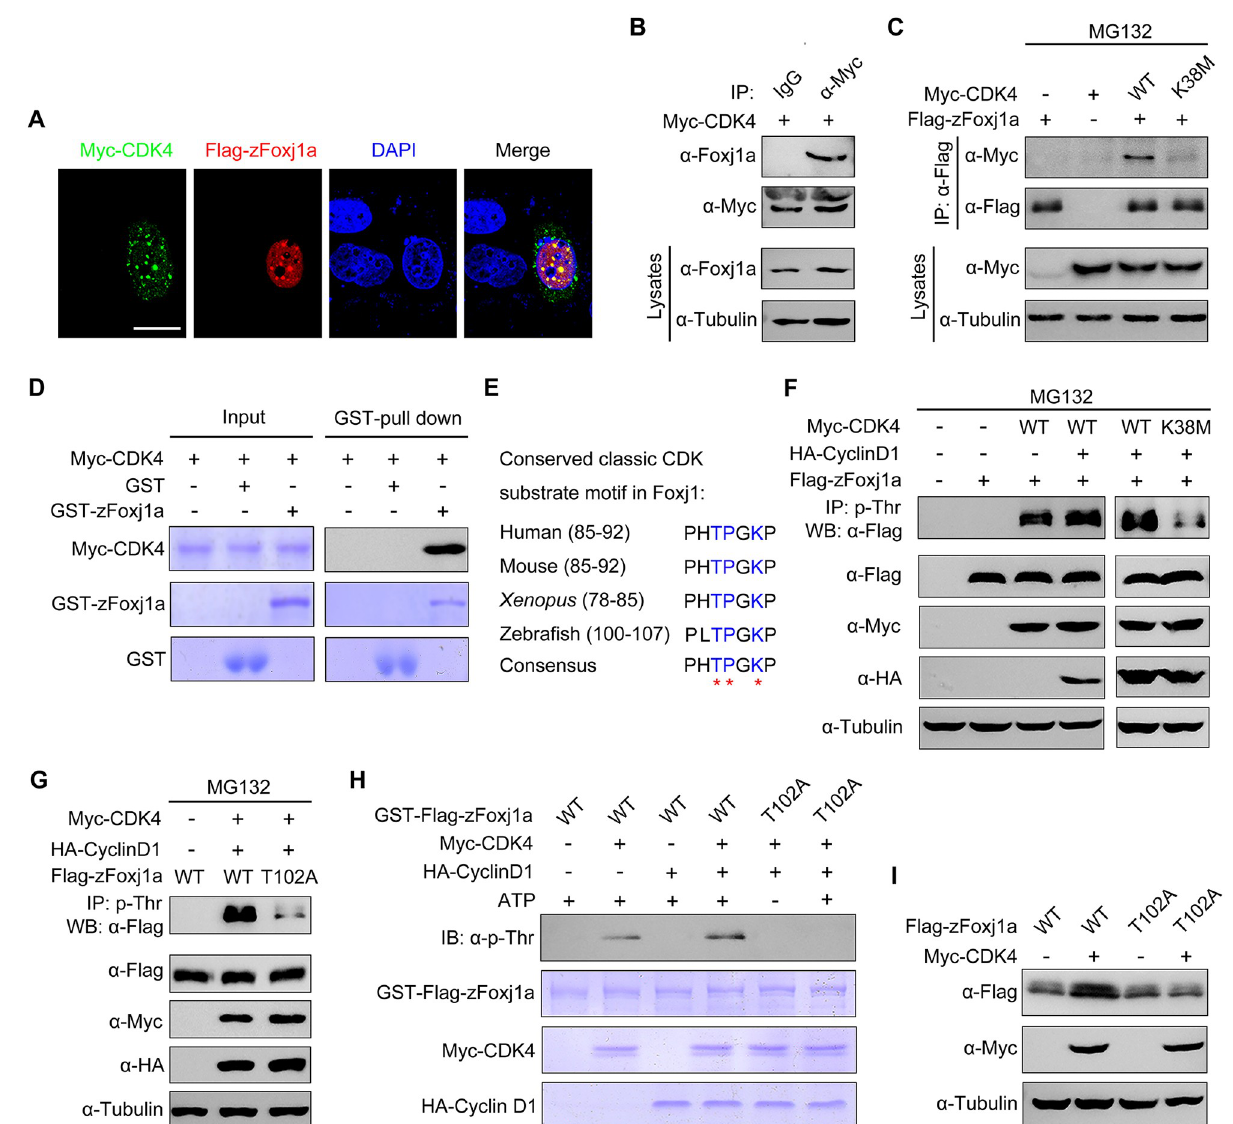
Fig 6. CDK4 phosphorylates zFoxj1a at T102 to suppress its degradation. (A) zFoxj1a and CDK4 show evident colocalization in HeLa cells. HeLa cells were transfected with Flag-zFoxj1a and Myc-CDK4 and immunostained with anti-Flag (red) and anti-Myc (green) antibodies. Nuclei were stained with DAPI (blue). Scale bar, 20 μ m. (B) Overexpressed CDK4 interacts with endogenous zFoxj1a. WT embryos were injected with 200 pg Myc-CDK4 mRNA at midgastrulation and then harvested at the bud stage for immunoprecipitation with anti-Myc antibody or normal mouse IgG. (C) CDK4, but not its kinase-deficient mutant, interacts with zFoxj1a. HEK293T cells were transfected with plasmids as indicated, followed by treatment with MG132 for 5 hours prior to harvest for immunoprecipitation. (D) Direct binding of CDK4 to zFoxj1a in vitro. GST, GST-zFoxj1a, and Myc-CDK4 were expressed in bacterial cells and purified. Myc-CDK4 proteins were incubated with GST or GST-zFoxj1a. The presence of Myc-CDK4 in the protein complex pulled down by glutathione agarose was assessed using an anti-Myc antibody. Input proteins were examined by Coomassie blue staining. (E) Conserved CDK substrate motifs in Foxj1 proteins from different species. Red stars indicate critical residues in the CDK substrate motifs. (F–G) CDK4 phosphorylates zFoxj1a at T102. HEK293T cells were transfected with the indicated plasmids. CDK substrates were immunoprecipitated using a phospho-threonine–proline antibody and blotted with anti-Flag antibody to detect phosphorylated zFoxj1a or zFoxj1a-T102A. zFoxj1a-T102A is an unphosphorylated form of zFoxj1a. Note that WT zFoxj1a could be phosphorylated by CDK4 but not by the CDK4-K38M mutant (F). CDK4-mediated phosphorylation was nearly abolished in zFoxj1a-T102A (G). (H) In vitro kinase assays revealed that CDK4 phosphorylates WT zFoxj1a but not the zFoxj1a-T102A mutant. zFoxj1a and zFoxj1a-T102A proteins were purified from bacterial cells and incubated with recombinant Cyclin D1 and CDK4 proteins in the presence or absence of ATP. Phosphorylation of zFoxj1a and zFoxj1a-T102A was detected by western blot using a phospho-threonine– proline antibody, and input proteins were examined by Coomassie blue staining. (I) Ectopic CDK4 expression is unable to stabilize zFoxj1a-T102 mutant. Lysates from HEK293T cells transfected with the indicated plasmids were subjected to immunoblotting. CDK, cyclin-dependent kinase; Foxj1a, forkhead box j1a; GST, glutathione S-transferase; HA, hemagglutinin; HEK, human embryonic kidney; IgG, immunoglobulin G; IP, immunoprecipitation; T102, threonine 102; WB, western blot; WT, wild-type; zFoxj1a, zebrafish Foxj1a; α -Tubulin, acetylated tubulin.